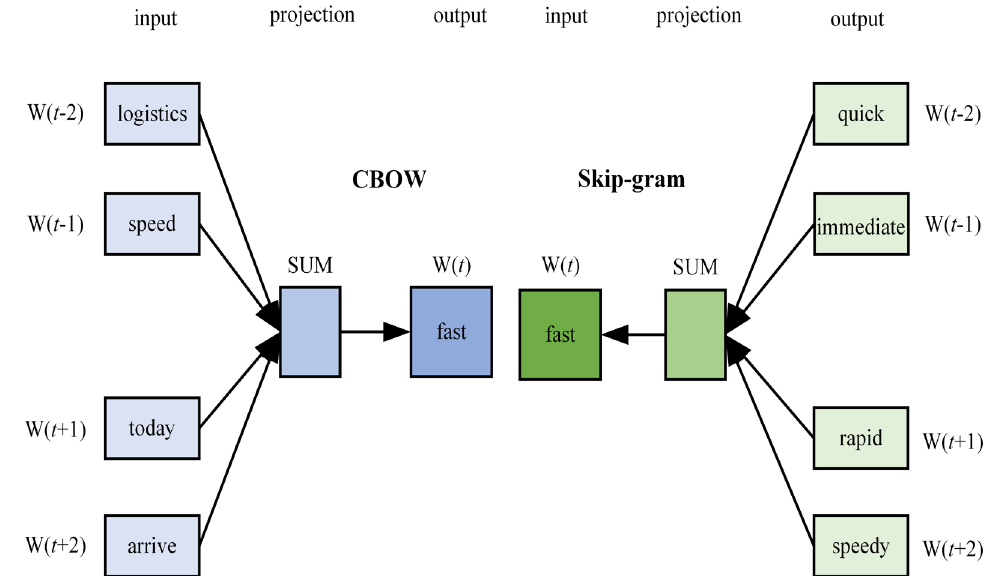
Figure 3. CBOW and Skip −